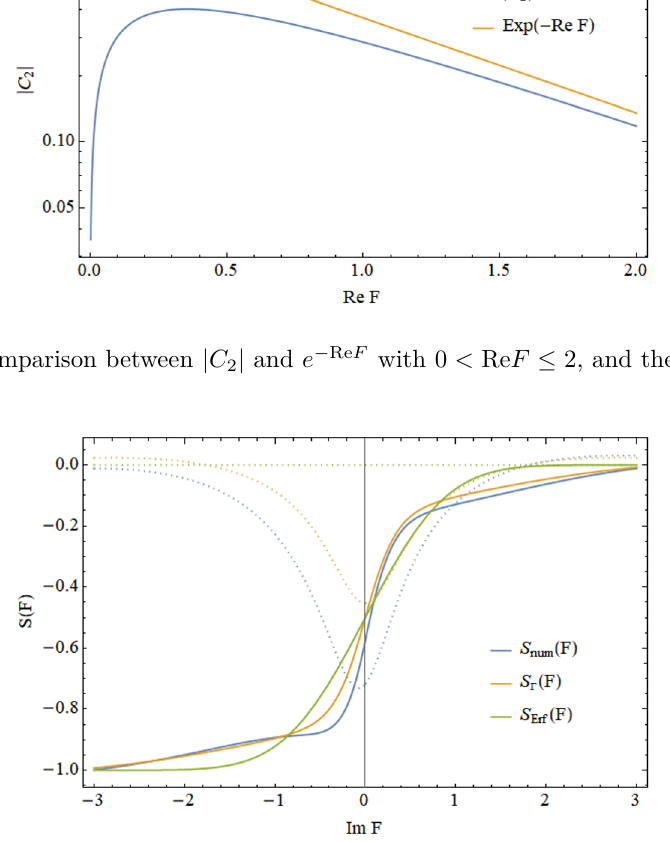
Figure 3 . The comparison between S num ( F ) , S Γ ( F ) and S Erf ( F ) , where all of them are normalized such that the final value approaches − i and Re F = 0 . 5 . The solid lines represent the imaginary parts, whereas the dashed lines are the real